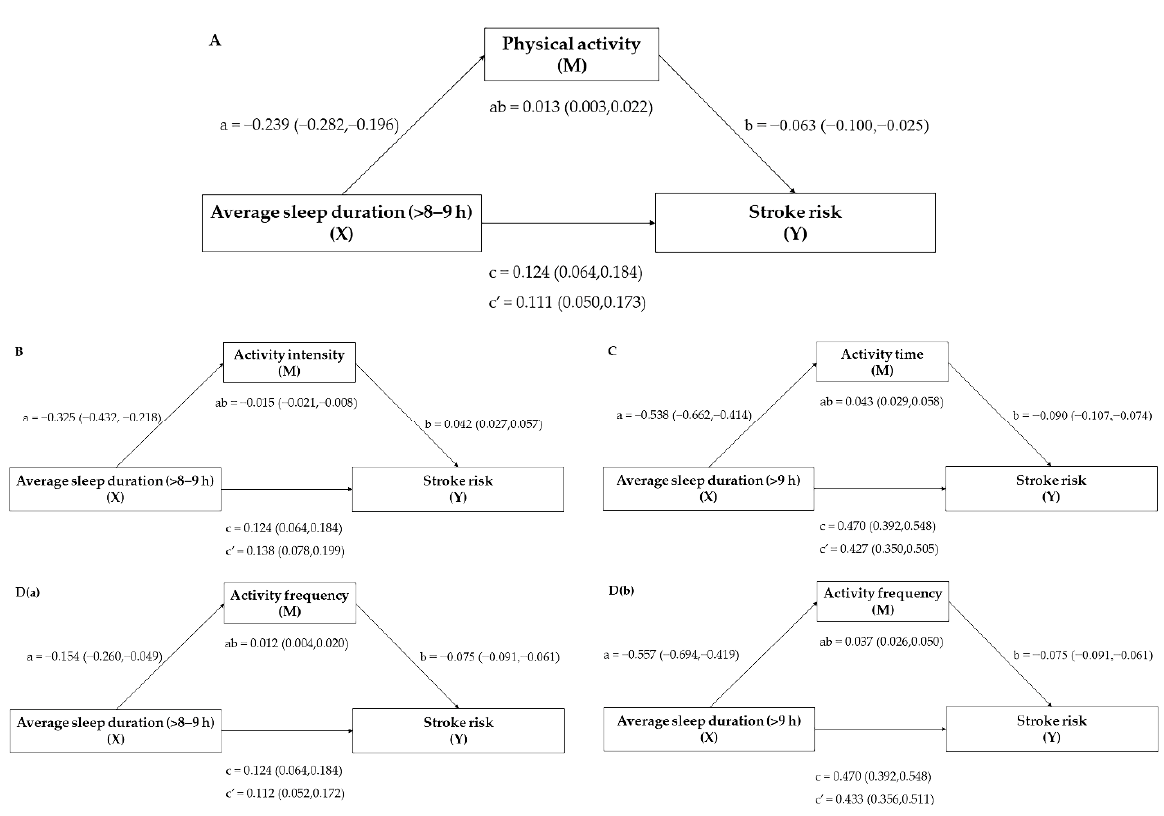
mediated by physical activity total score; ( B ) for the relationship between a sleep duration of >8~9 h